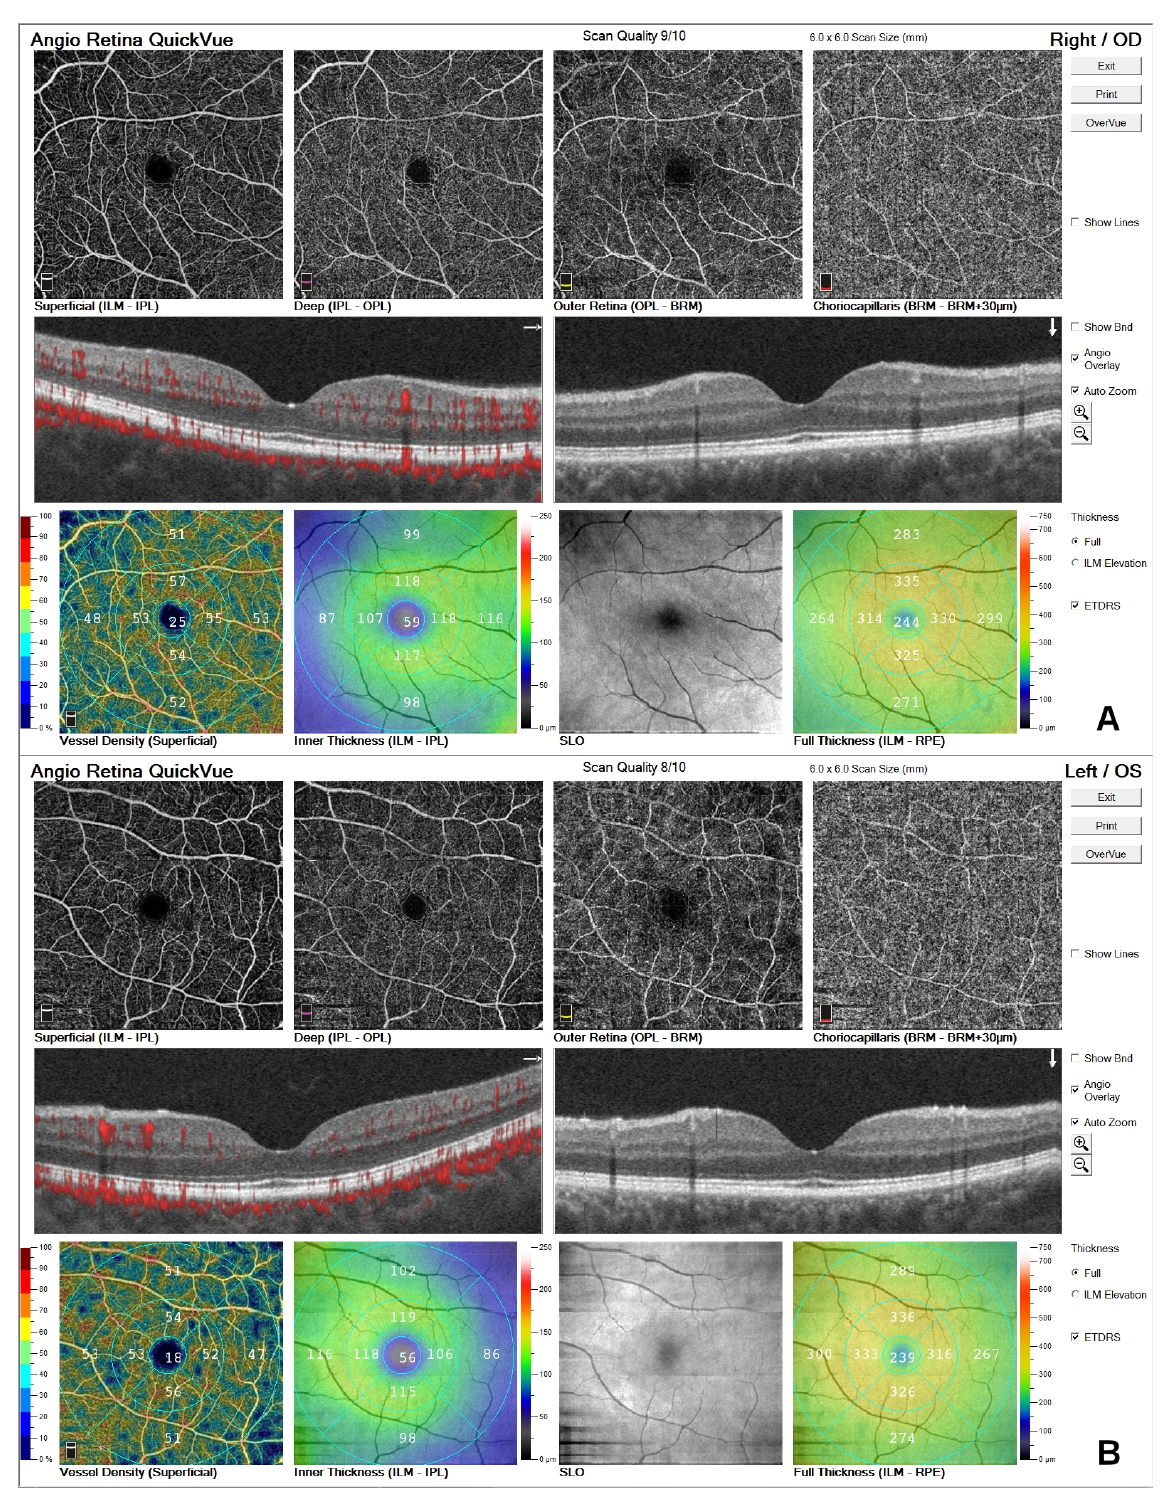
Figure 5: Normal OCTA and OCT at 6 th month; A) OD, B)